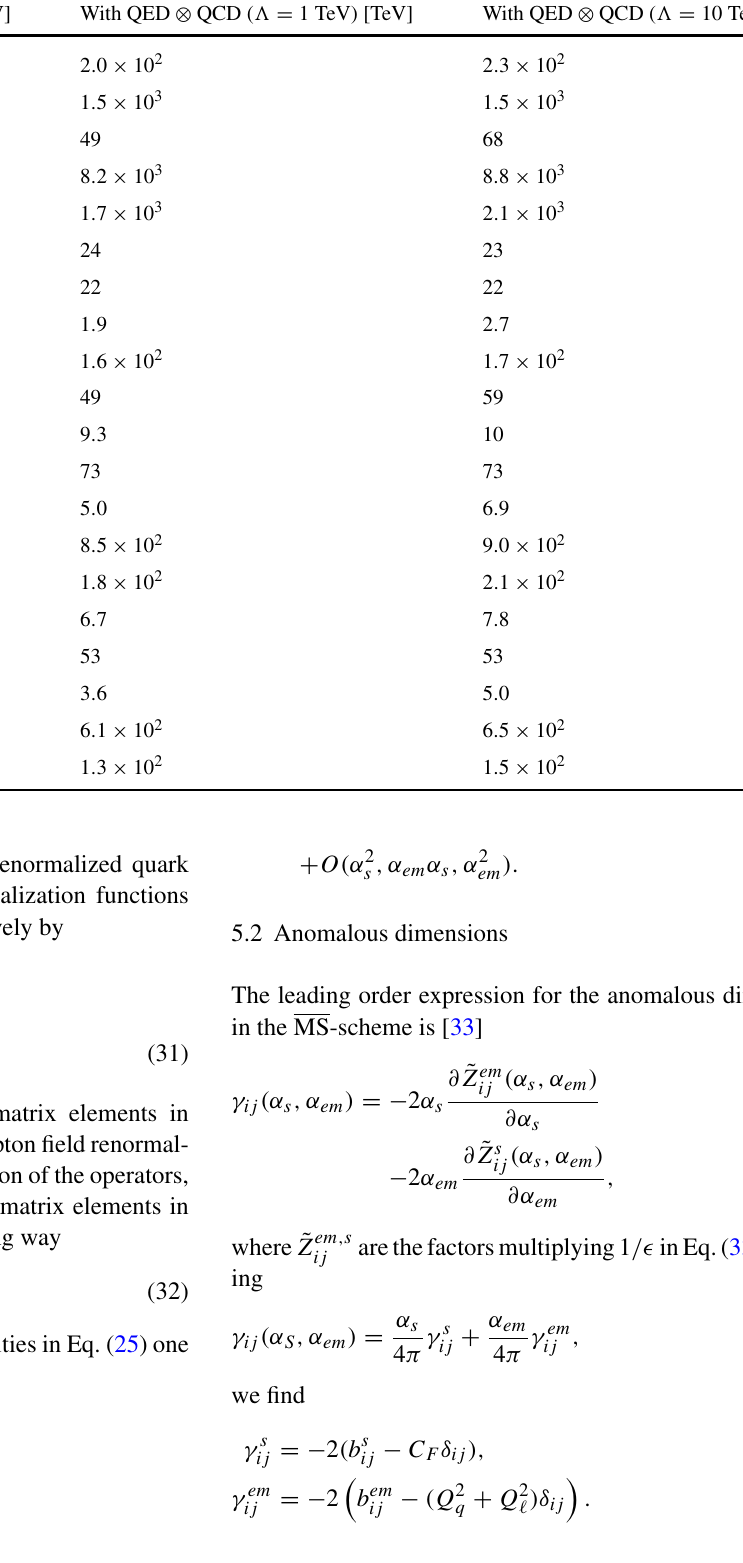
Table5 LowerlimitsontheindividualLFVscales (cid:7) (cid:2) = μ e ) associated to the Wilson coefficient C ( q 1 q 2 ) AB (cid:2) 1 2 inition of the LFV scale, see Eq. (19). The limits without corrections are obtained from the limits on the LFV decays, M → (cid:2) ±